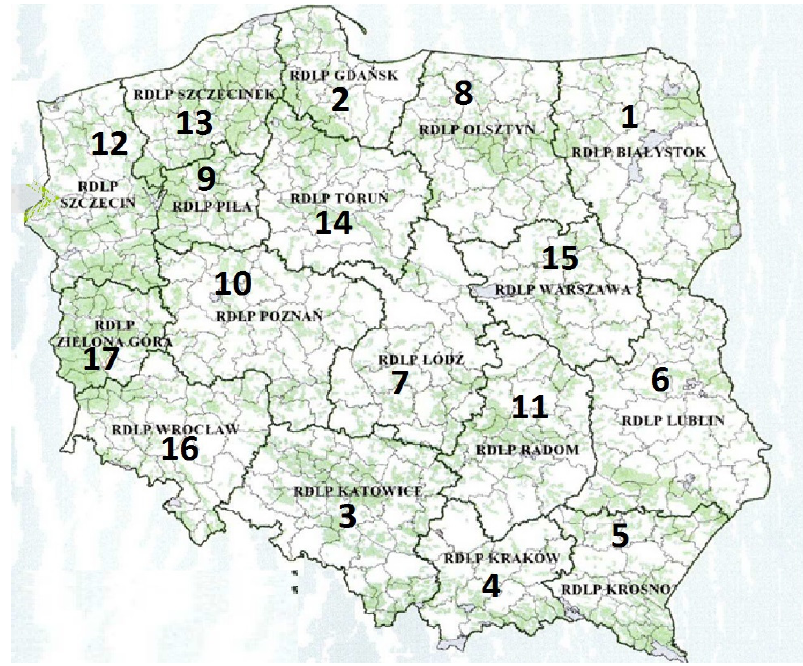
Figure 1. Separation of the zones of forest managers (RDSF: Regional Directorate of State Forests) in the territory of the country within the PGLLP. Table 1. Adopted structure of the designation of forest managers (RDSF) in the territory of Poland [88–90].